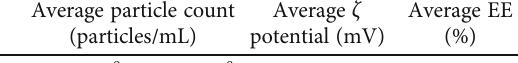
Average particle count (particles/mL)